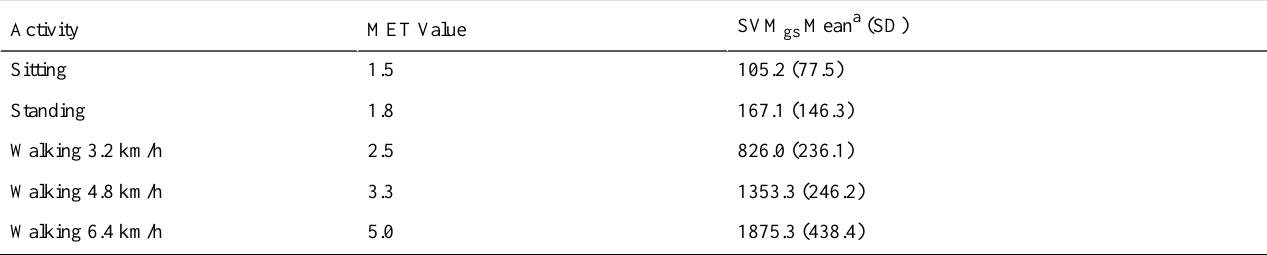
Table 1. Mean GENEA SVM gs (g·min) output for the five activities included in the calibration study.